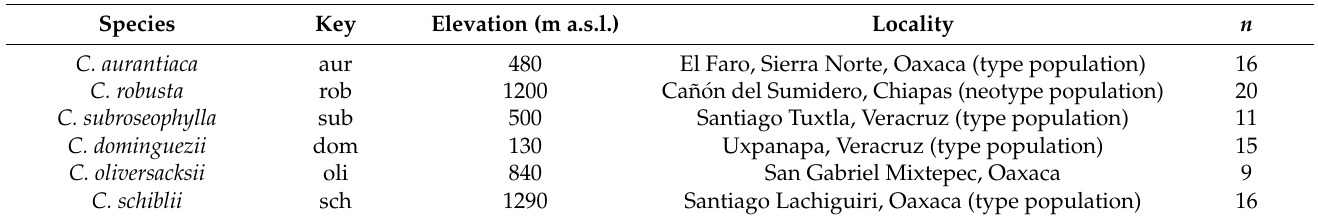
Table 1. Species compared in this study. Name of sampling locality, elevation in m above sea level (a.s.l.), and number of samples analyzed ( n ) in morphometric analyses are provided. Species Key Elevation (m